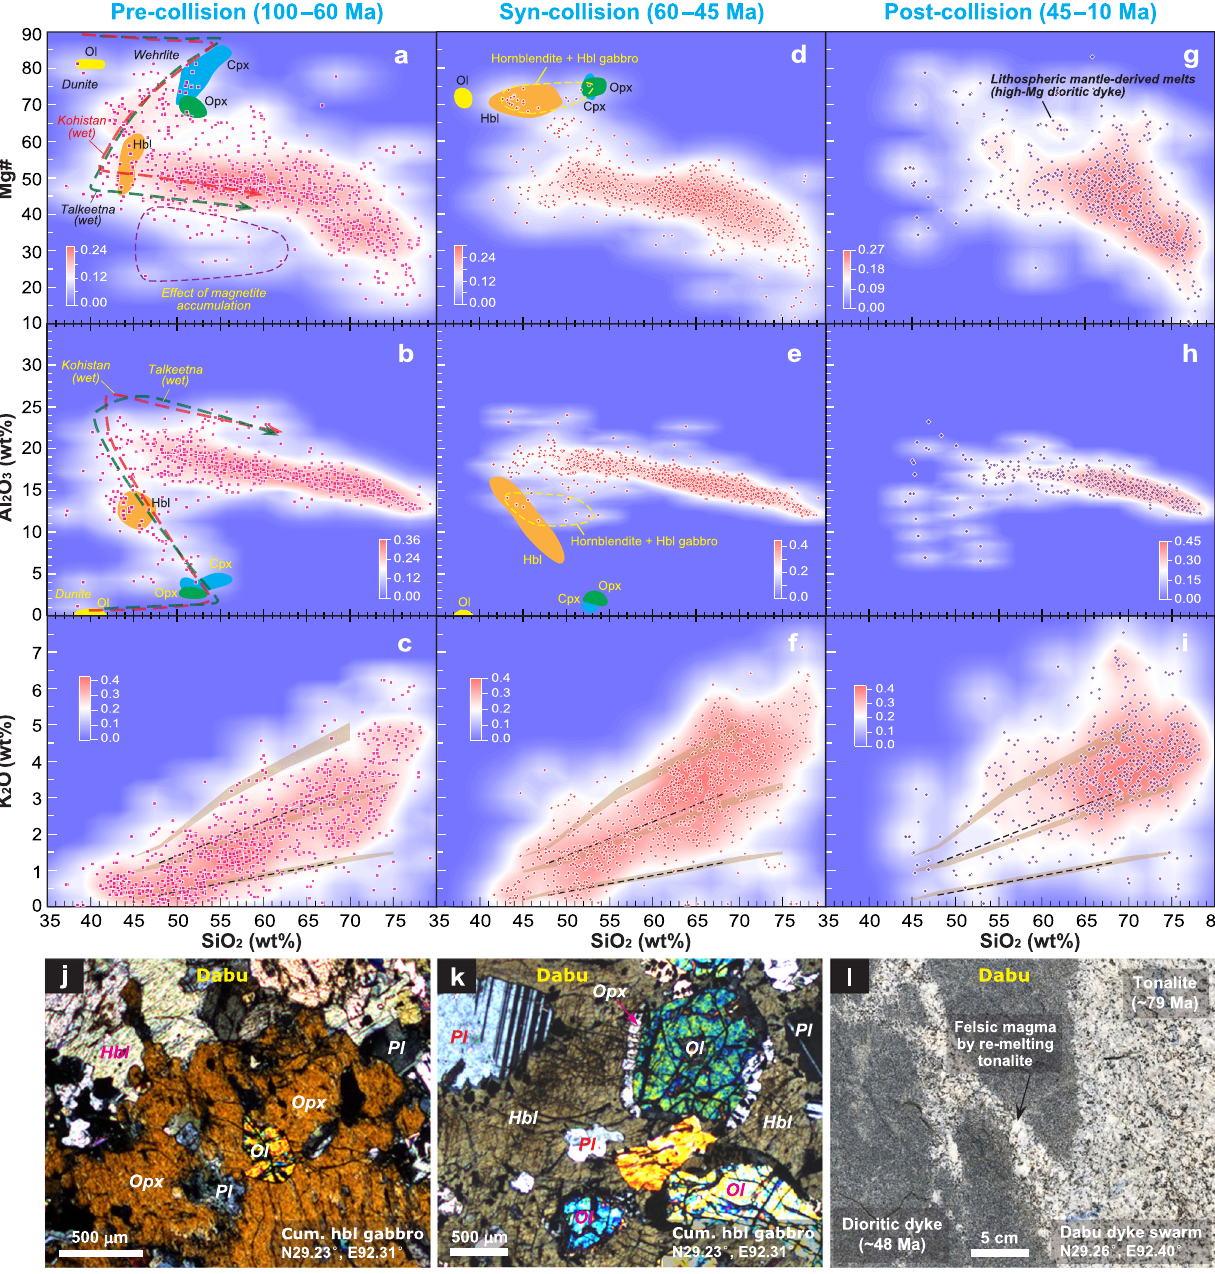
Hbl gabbro from Dabu, where j shows Pl included in Opx surrounded by Hbl, and k showsHblformedbyOpx+liquidreactionandOpxrimsaroundOlcausedbythe peritectic reaction Ol + liquid = Opx. These relationships indicate a damp envir- onment where Hbl is last to crystallize at the end of the sequence Ol → Opx → Opx+Pl → Hbl. l Detail at the contact between a syn-collisional dioritic dyke (~48Ma) and an older tonalite (~79Ma) resulting in the remelting of the tonalite and back-veining of the dyke. Mg# = molar 100×Mg 2+ /(Mg 2+ +TFe 2+ ), where TFe 2+ represents total Fe. Whole-rock and mineral compositions are given in Supple- mentary Table 1, and 3. Mineral abbreviation: Ol olivine, Cpx clinopyroxene, Opx orthopyroxene, Hbl hornblende, Pl